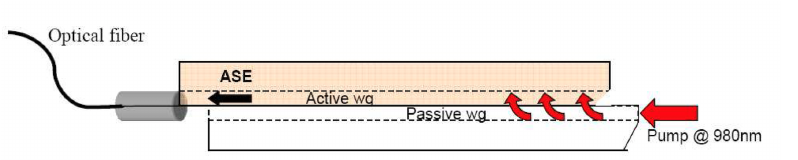
Figure 10. Longitudinal view of the hybrid waveguide amplifier test structure, constituted by a multimode passive waveguide ( bottom ) and a single mode active Er/Yb doped waveguide ( top ). A large area laser diode pump is coupled to the multimode waveguide, and the propagating beam is progressively coupled to the active layer. Energy is absorbed by Yb ions and then transferred to Er ions. Reproduced from [160] with permission by Optical Society of America.